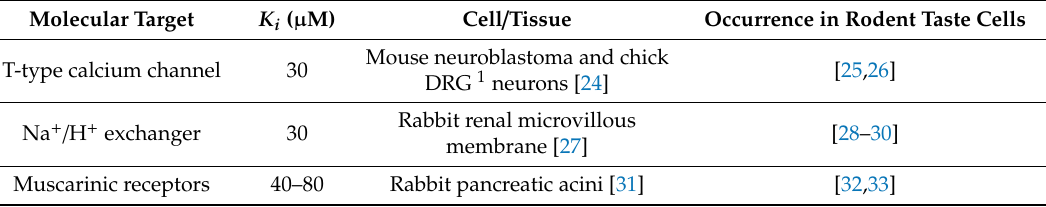
Table 1. Molecular targets, other than ENaC, for the inhibitory e ff ect of amiloride expressed by the inhibition constant ( K i = amiloride concentration producing 50% inhibition). Data refer to nontaste tissues. The occurrence of these molecular targets in rodents taste cells is also